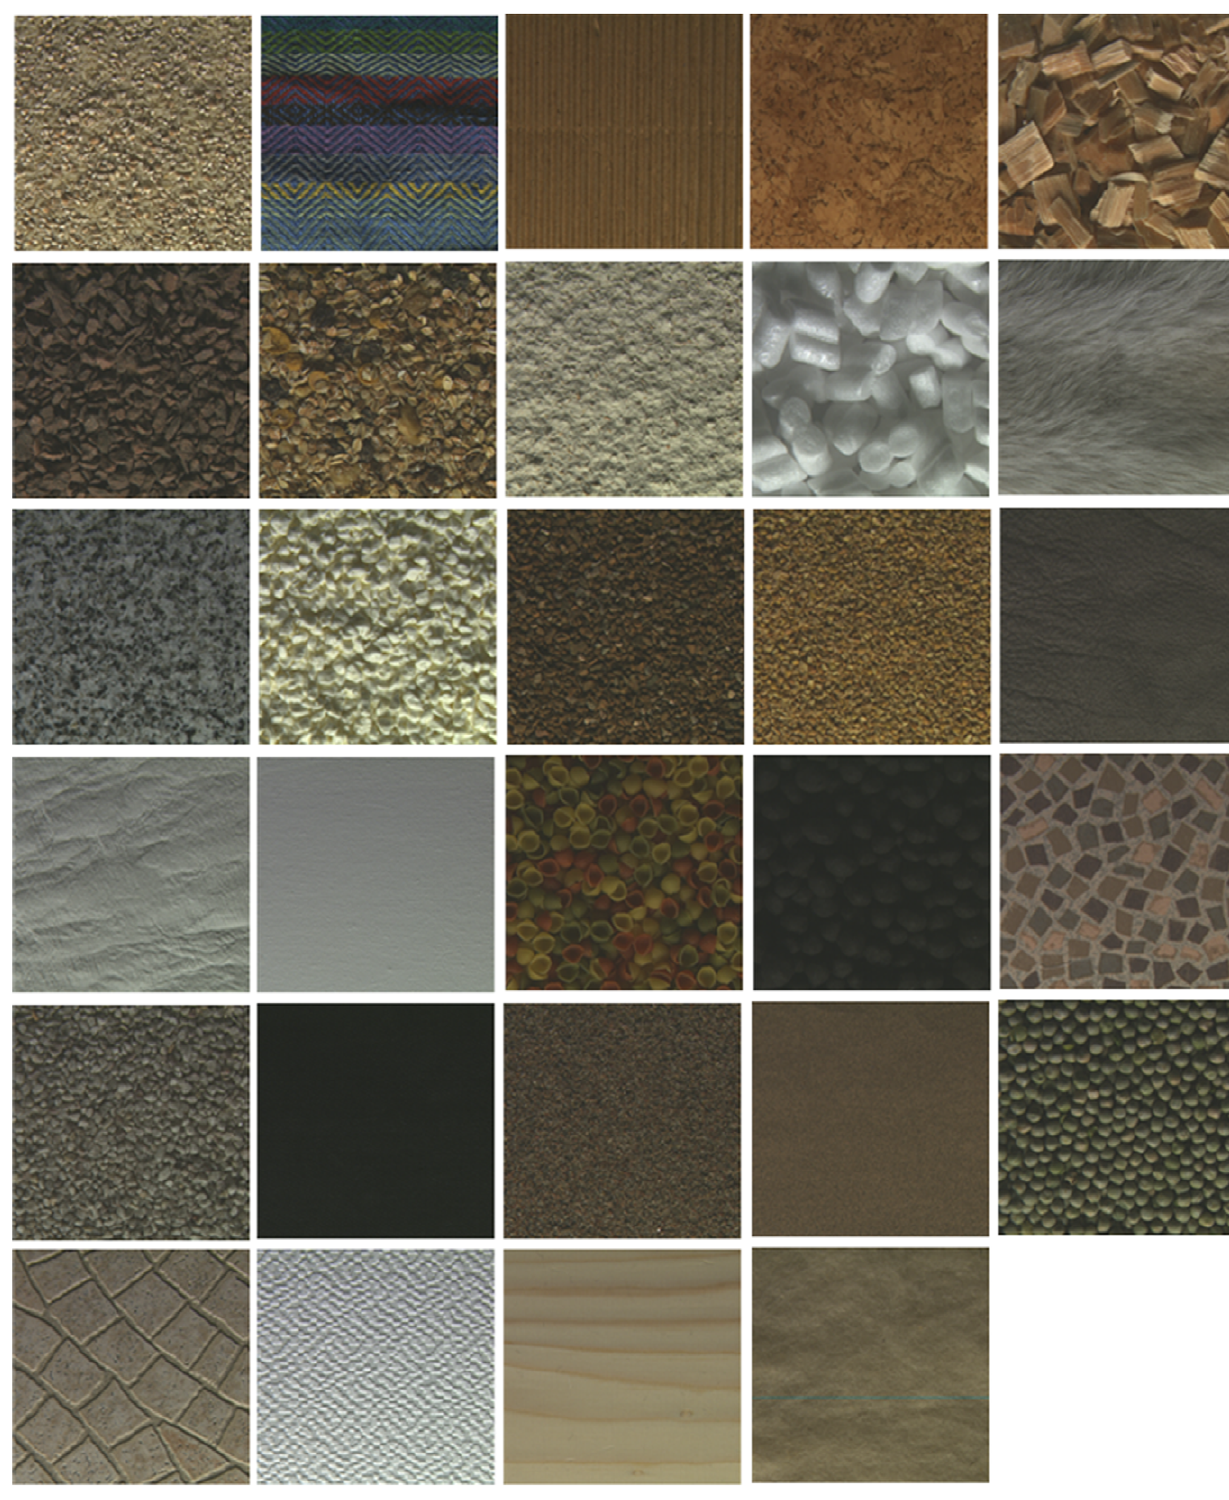
Figure 4. One example from each category in the Outex texture database.